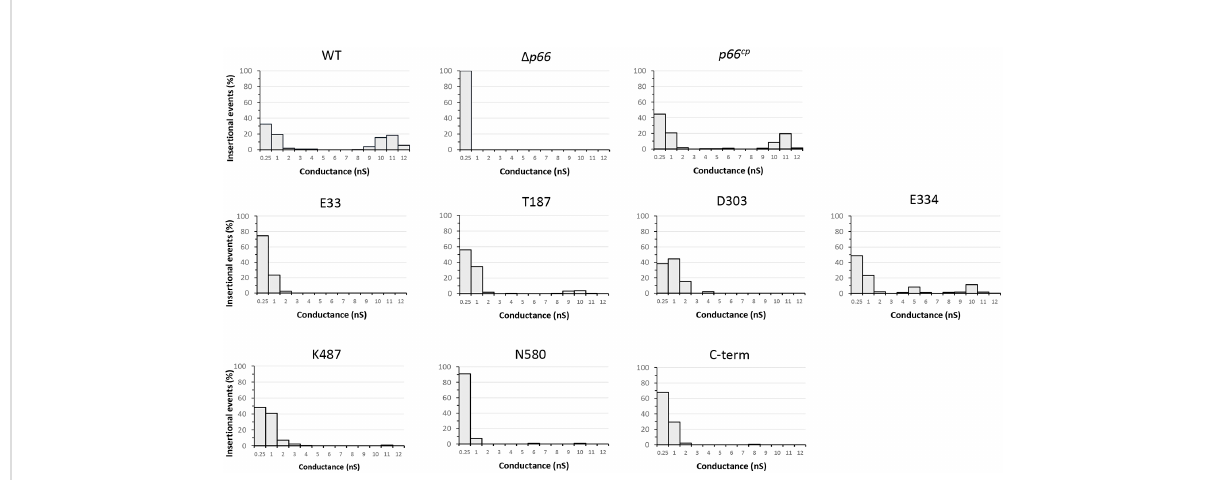
FIGURE 6 Black lipid bilayer analyses reveal different porin activities of outer membrane fractions of strain B . burgdorferi B31 A3 WT, D p66 , and c-Myc P66 cp derivative strains. The histograms of the single-channel conductance distributions were obtained from at least 100 insertional events derived from at least three different membranes. Outer membrane fractions were diluted in 1% Genapol and added to the lipid bilayer in 1 M KCl. The applied voltage was 20 mV. The experiment was performed in duplicate (or in triplicate for C-term) for all strains with one representative shown. The conductance was measured in nano-Siemens